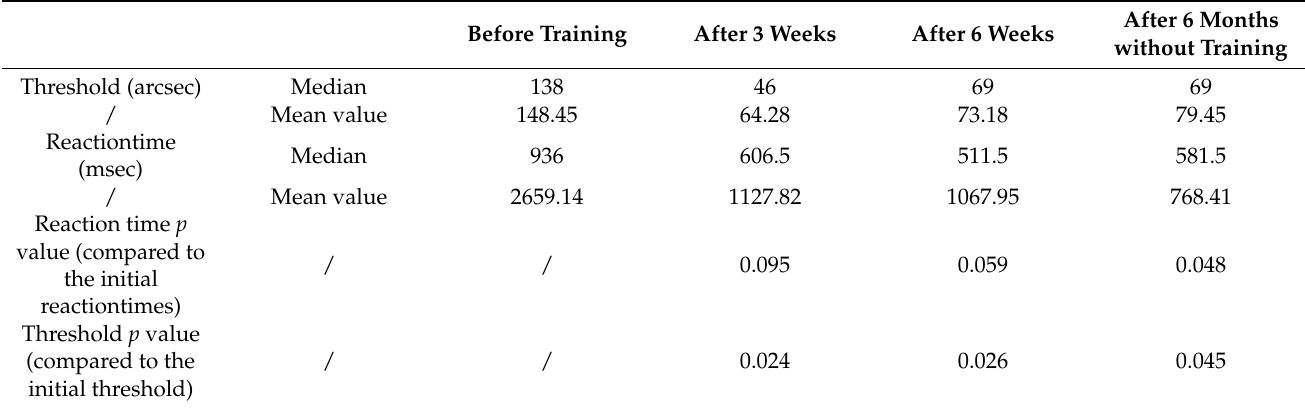
Table 3. Representation of the development of the median and mean value of the entire sample group’s stereoacuity, reaction time, and level of significance in the static test.